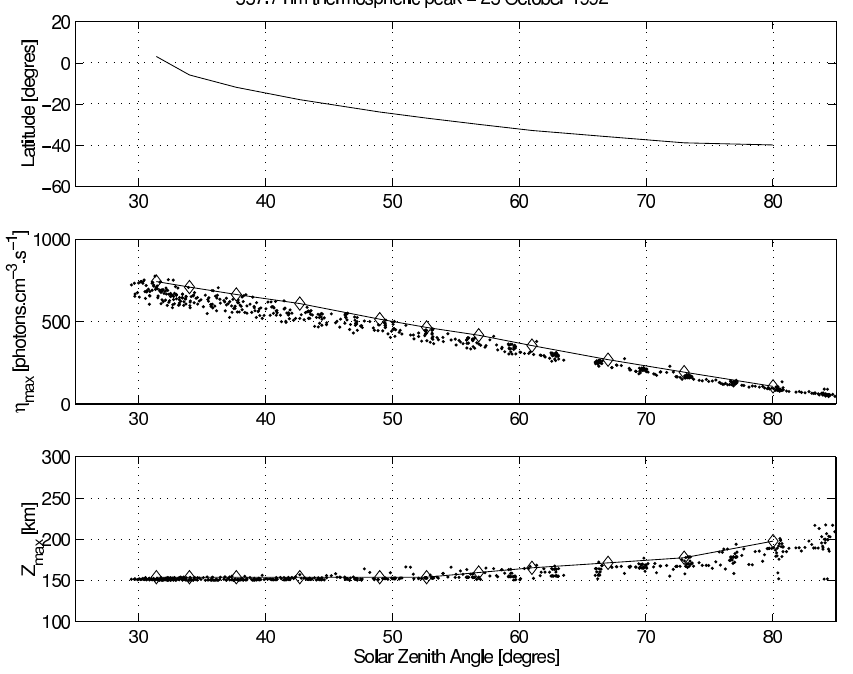
Fig. 9. 557.7nm oxygen thermospheric line – 25 October 1992 – f 10 . 7 = 146 . 8 ,A p = 7. Dots correspond to WINDII measurements and line/diamonds correspond to TRANSCAR results.